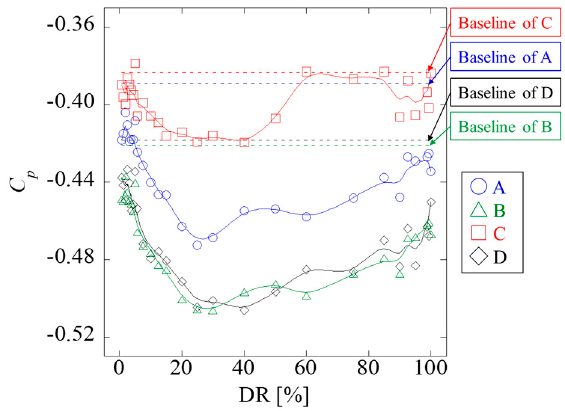
Figure 19. C p as a function of duty ratio (DR). Symbols A, B, C, and D indicate measured positions on the model surface shown in Figure 5.